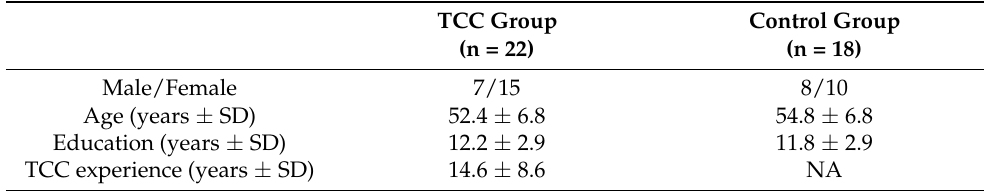
Table 1. Demographic